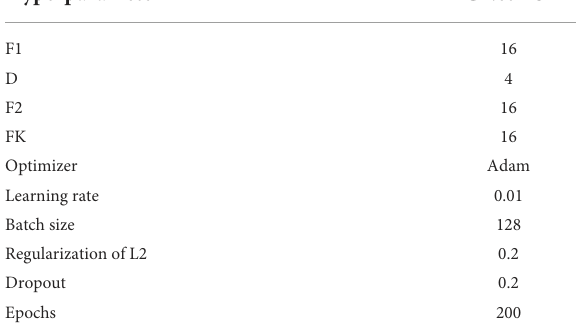
the large search result, which EEGNet-LSTM decoder, when using the Physiobank EEG